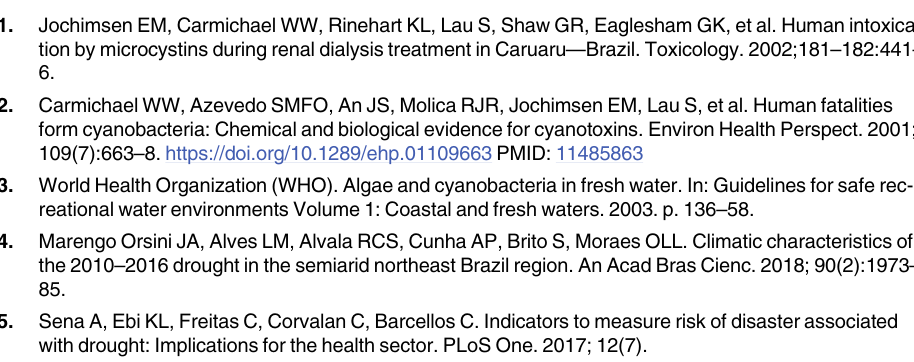
lines were used to delimitate the boundaries of the cell layer. White lines show the cell